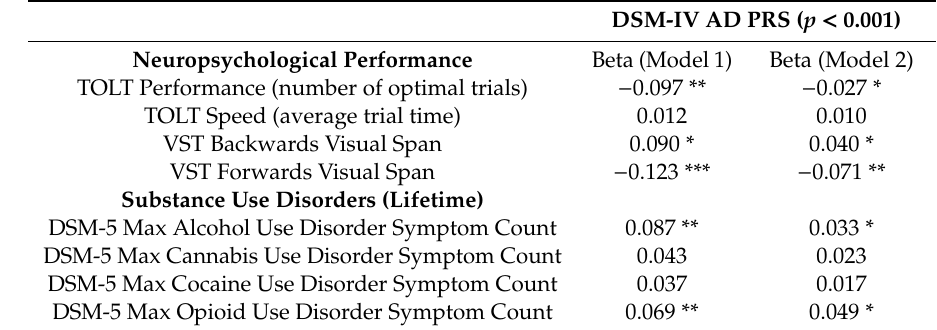
Table 3. Association of AD PRS ( p < 0.001) with neuropsychological performance and symptoms of DSM-5 alcohol, cannabis, cocaine, and opioid use